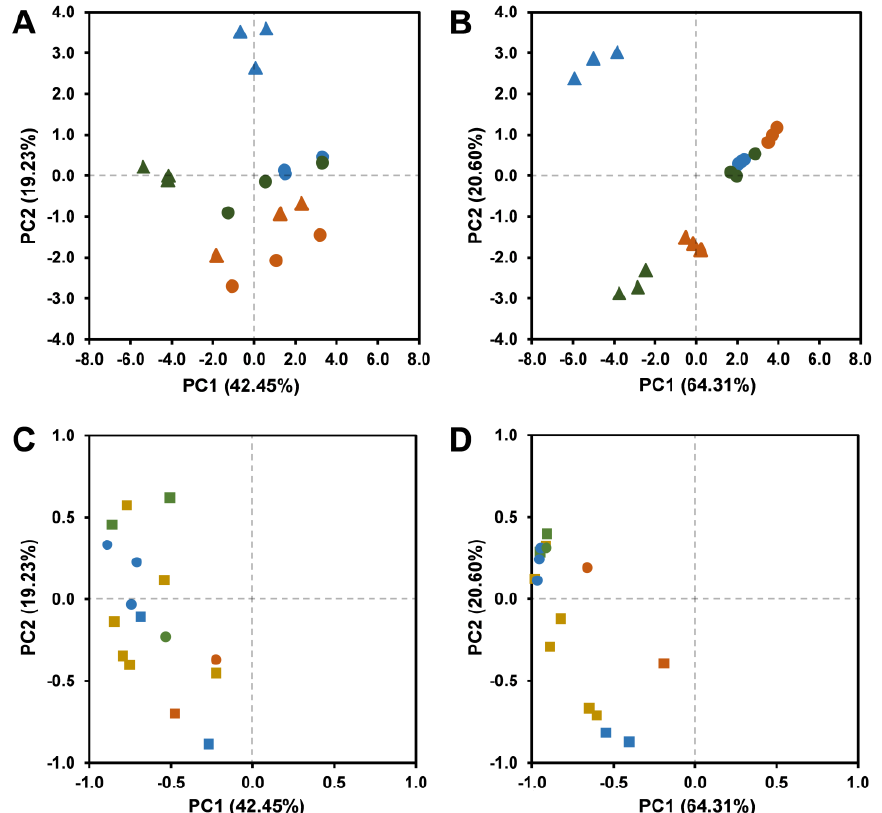
Figure 5. Correlation of T. carnosus hydroethanolic ( A , C ) and aqueous decoction ( B , D ) extracts’ phe- nolic profile and correlation to phenolic compounds quantified by HPLC-DAD represented as principal component analysis (PCA) scores. Samples were organized using the following shape – colour pattern: A and B : L1- ▲ , L2- ● , 2018 — orange, 2019 — blue, 2020 — green; C and D : caffeic acid —● ,